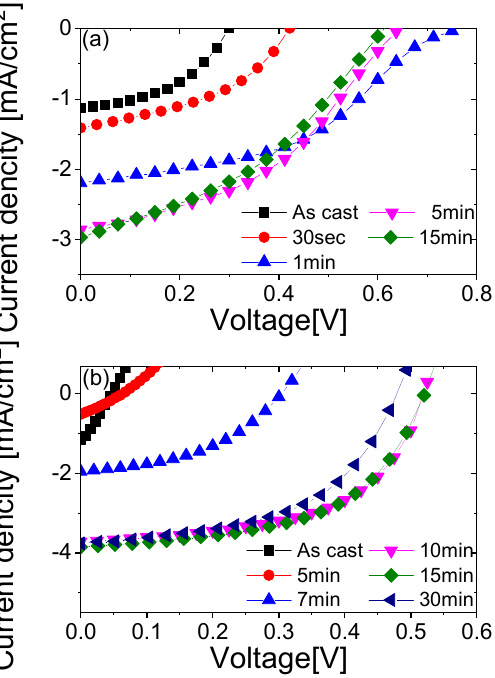
Figure 7. Representative current-voltage characteristics measured under solar cell illumination prepared by solvent vapor annealing of ( a ) PC 70 BM/PCDTBT and ( b ) P3HT/PC 60 BM bilayers for different time periods.